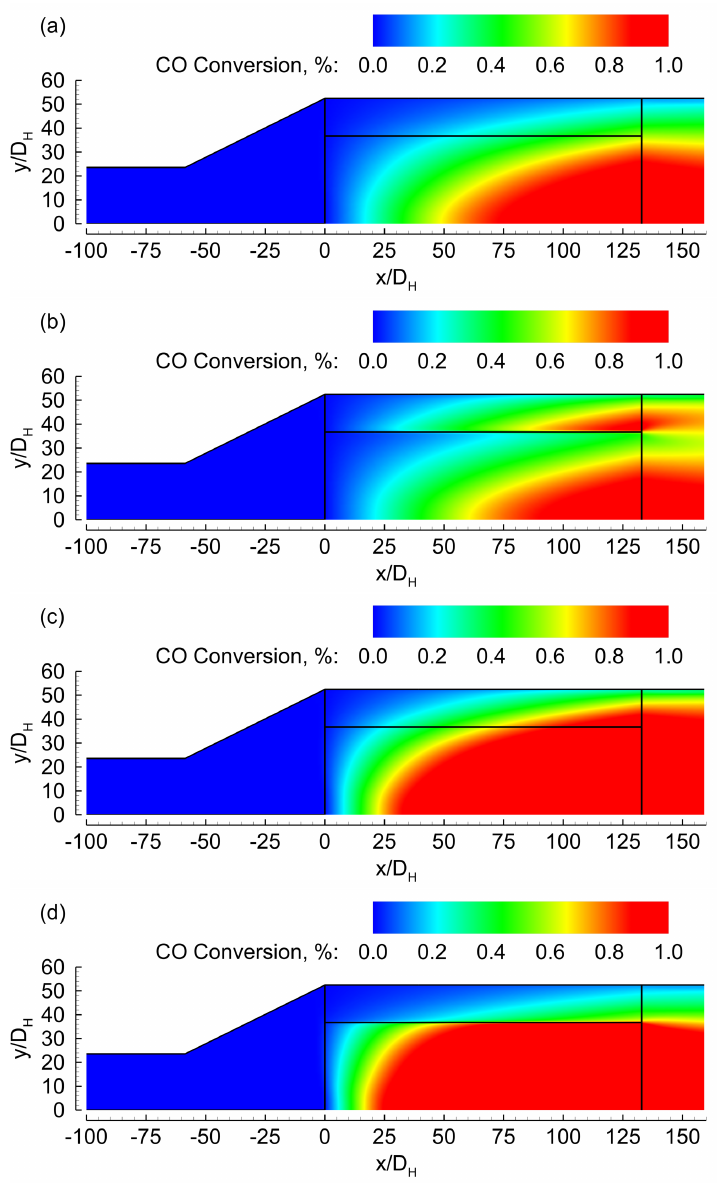
Figure 6. Temperature profile at the outlet of the catalytic zone. 1